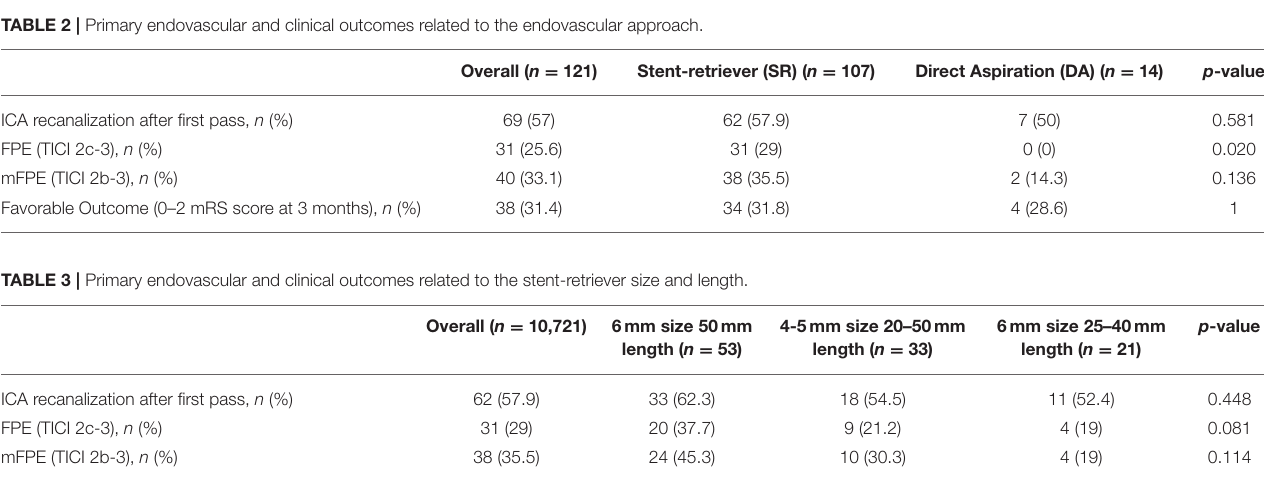
TABLE 2 | Primary endovascular and clinical outcomes related to the endovascular approach.